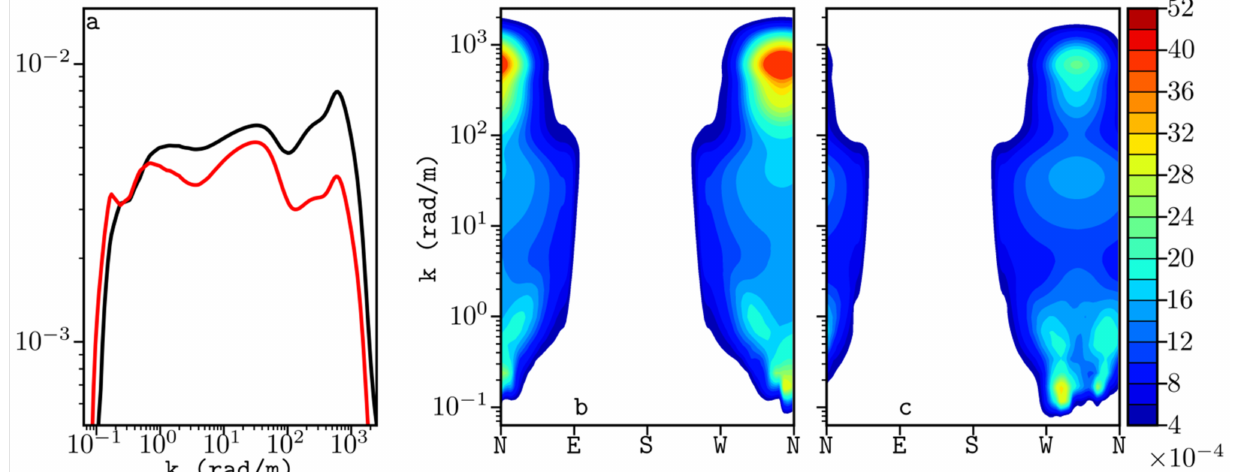
Figure 3. ( a ) Azimuthally integrated saturation spectrum B o ( k ) of the directional spectrum at the east-central Aegean (black line) and at the southeast Aegean (red line). Directional saturation spectrum B ( k , φ ) from flight segments, ( b ) west of Chios (Figure 2a, black and white circle) and ( c ) south of Karpathos (Figure 2b, black and white